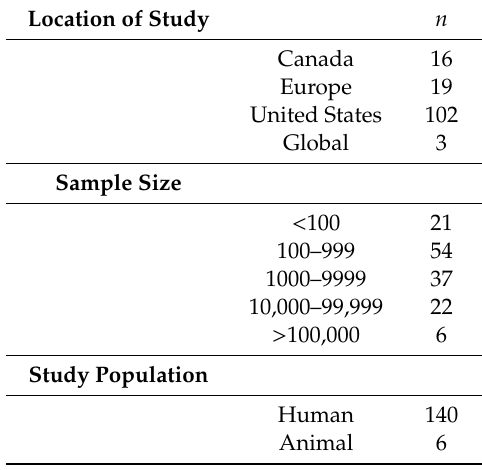
Table 1. Summary of the characteristics of the studies included in this